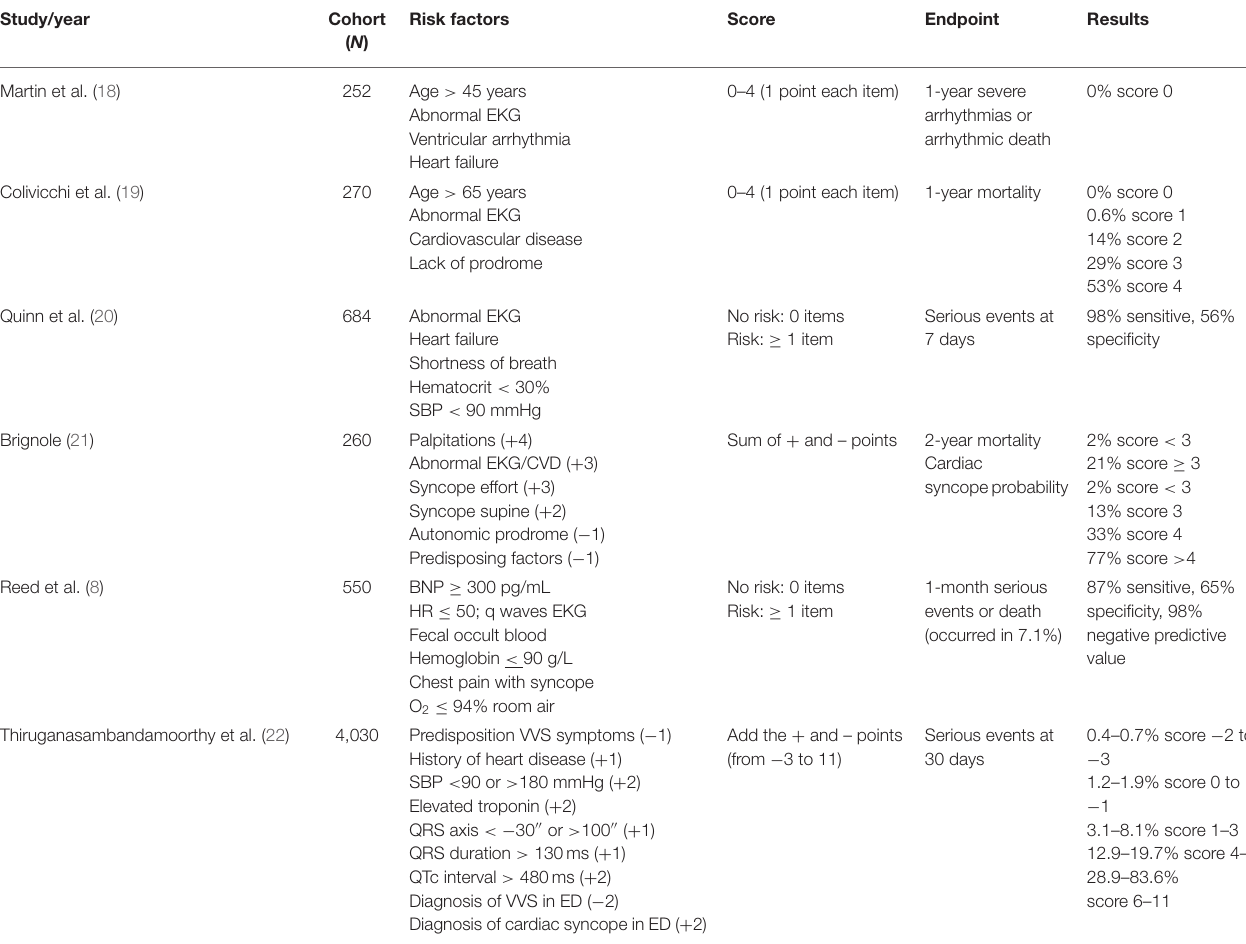
TABLE 1 | Example of syncope risk scores evaluated in prospective studies.